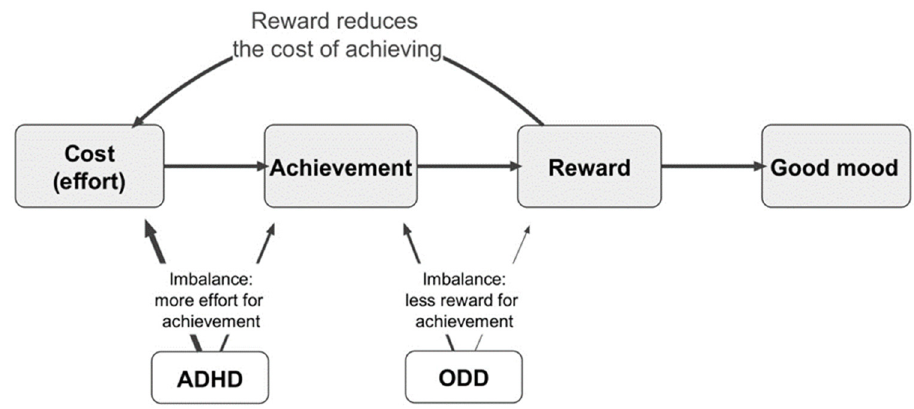
Figure 1. Mental Effort-Reward Imbalances Model (MERIM). Figure reproduced with permission by Australasian Psychiatry [11].